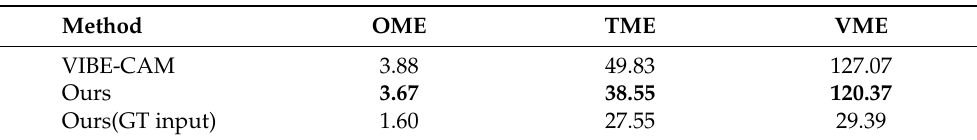
Table 8. Quantitative comparison between the proposed method and VIBE-CAM on the 3DPW dataset. Ours (GT input) indicates that the ground-truth local pose is used as the input of GMR. The best results are shown in bold.